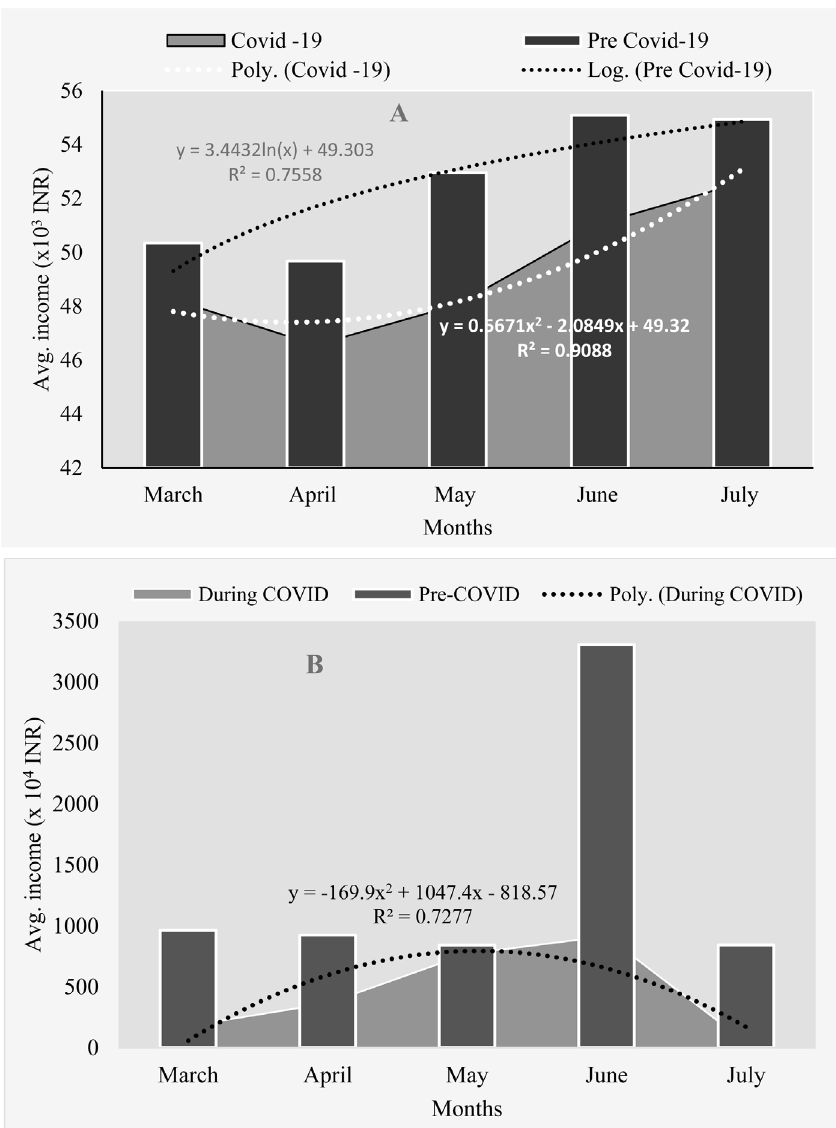
Fig. 5. Monthly income during pre-COVID-19 and COVID-19 period of the farmers in Site-FW (A) and Site- BW